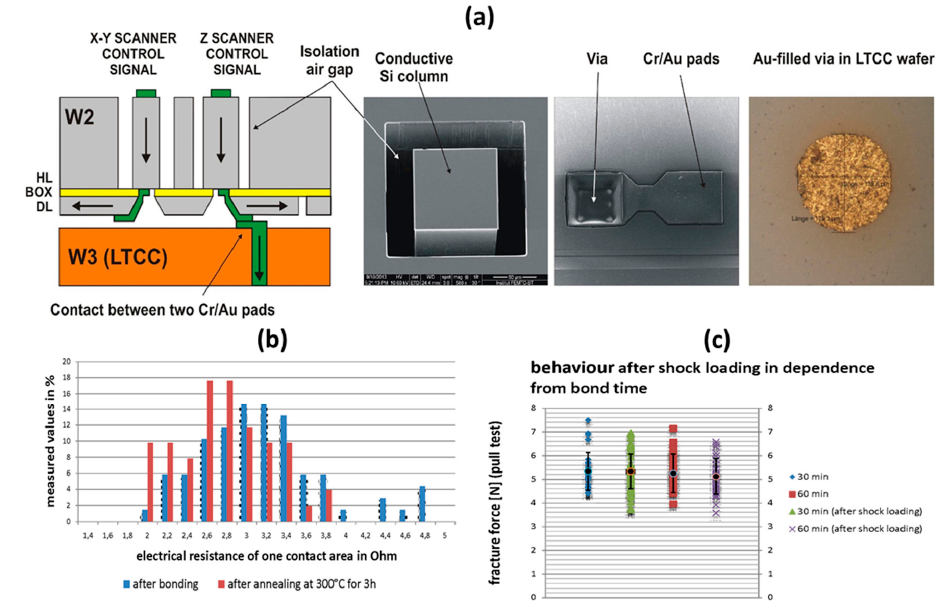
Figure 23. Electrical interconnection for individual microactuators, based on air-insulated conductive Si column, Cr/Au contact pads and Au-filled vias embedded in low temperature co-fired ceramic (LTCC): ( a ) details; ( b ) influence of annealing step on the electrical resistance of contact; and, ( c ) distribution of fracture force (pull test) before and after shock loading as a function of bonding time (30 min and 60 min).